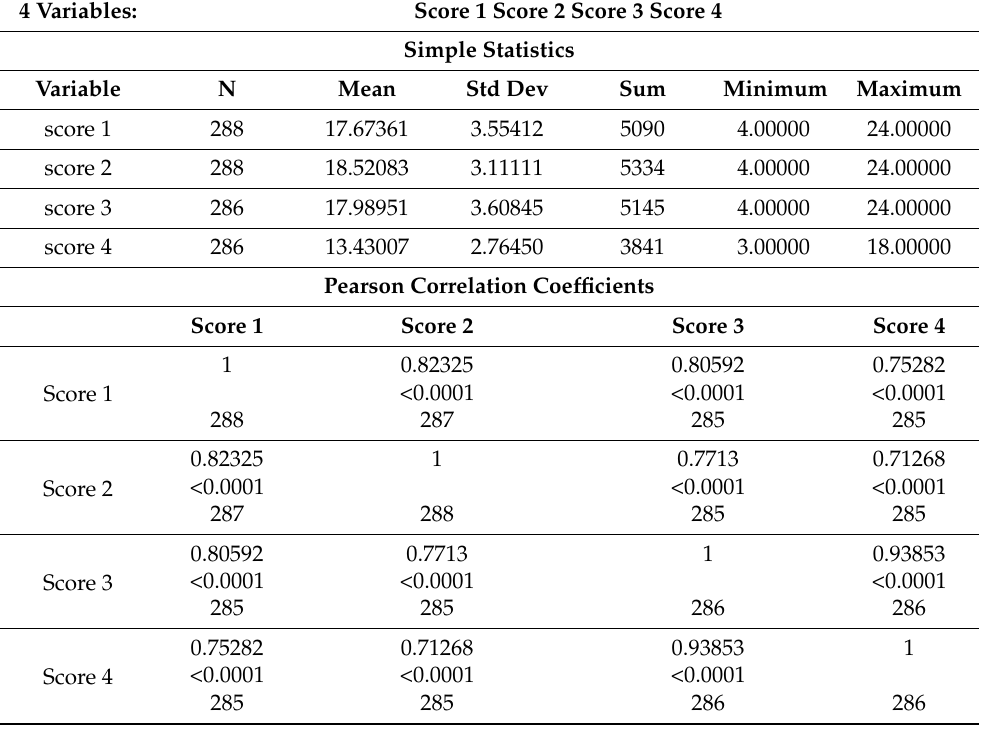
Table 6. The correlation of the